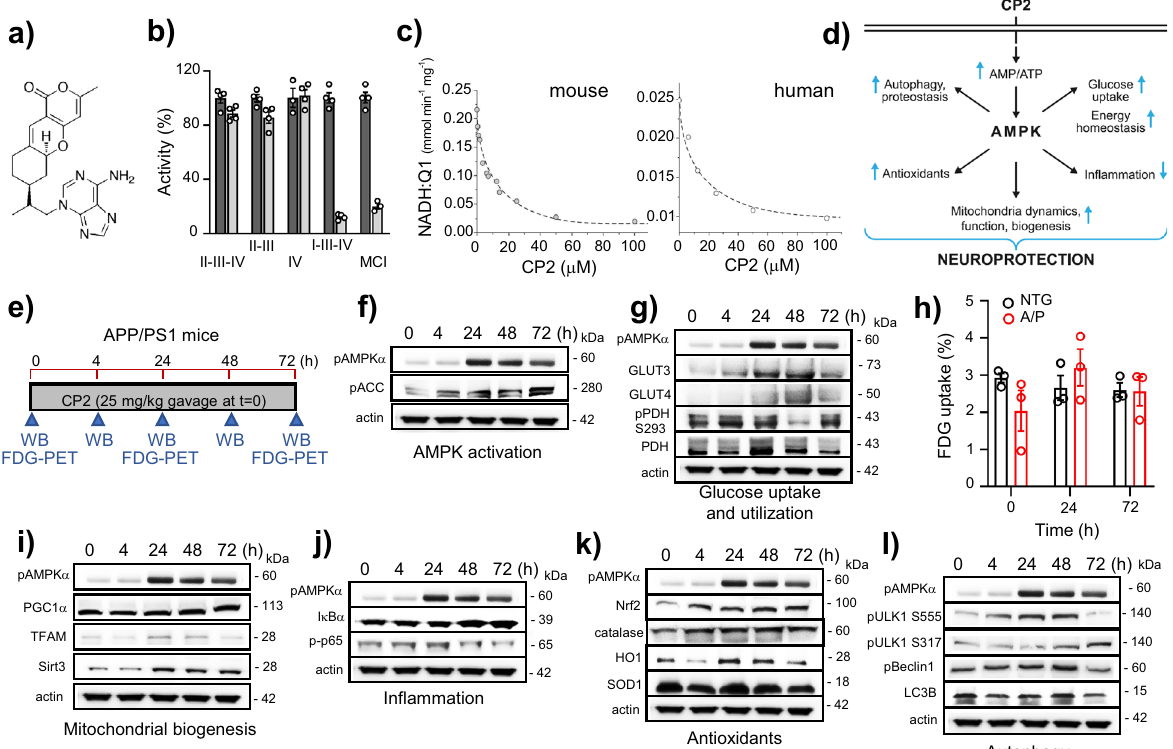
Fig. 1 Acute CP2 treatment activates multiple AMPK-dependent neuroprotective mechanisms in symptomatic APP/PS1 mice improving energy homeostasis in the brain. a CP2 structure. b CP2 (light gray bars, 50 mM) does not affect the activity of succinate oxidase (complexes II-III-IV), succinate: cytochrome c reductase (complexes II-III), and ferrocytochrome c oxidase (complex IV only), but signi fi cantly inhibits MCI affecting NADH oxidase (complexes I-III-IV) and NADH:ubiquinone (complex I only) in mouse brain mitochondria. Vehicle-dark gray bars. c CP2 inhibits MCI in mitochondria isolated from the mouse and postmortem human cortical tissue. d Neuroprotective pathways activated by CP2 in the brain converge on AMPK activation. e Timeline of acute CP2 administration via gavage (25 mg/kg) to APP/PS1 mice 9 – 10-month-old. Brain tissues from 1 mouse per each time point were examined using western blot analysis. Independent cohort of mice was subjected to the in vivo FDG-PET ( n = 3 mice per group). f – l Western blot analysis of brain tissue from acutely gavaged APP/PS1 mice from e con fi rms that CP2 activates multiple AMPK-dependent neuroprotective mechanisms in symptomatic APP/PS1 mice. h Untreated symptomatic APP/PS1 mice 9 – 10-month-old have reduced glucose uptake in the brain determined using in vivo FDG-PET compared to NTG littermates (time 0 h). Acute CP2 oral administration improves glucose uptake brining glucose levels in APP/PS1 mice to the same level as in untreated age-matched and sex-matched NTG mice (time 24 and 72 h); n = 3 mice per